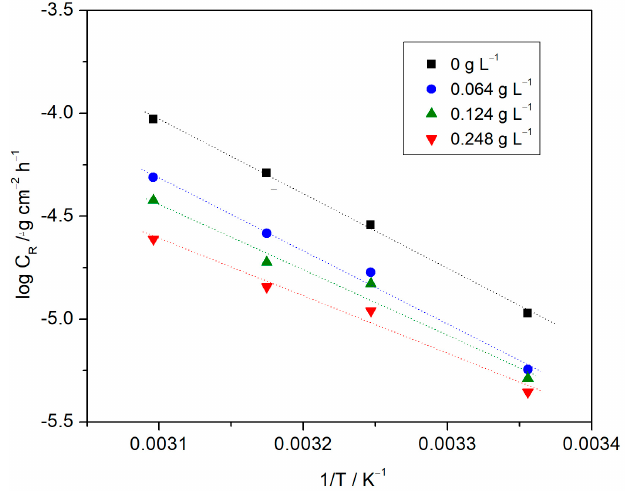
Figure 3. Arrhenius plots for the corrosion rate of aluminum in a 0.1 M HCl solution, in the presence and absence of Ilex paraguariensis extract. Table 2. Thermodynamic properties E a , ∆H 𝐚∗ and ∆S 𝐚∗ (see definitions in text) for aluminum in 0.1 M HCl blank solution and in the blank solution with different concentrations of Ilex paraguariensis .